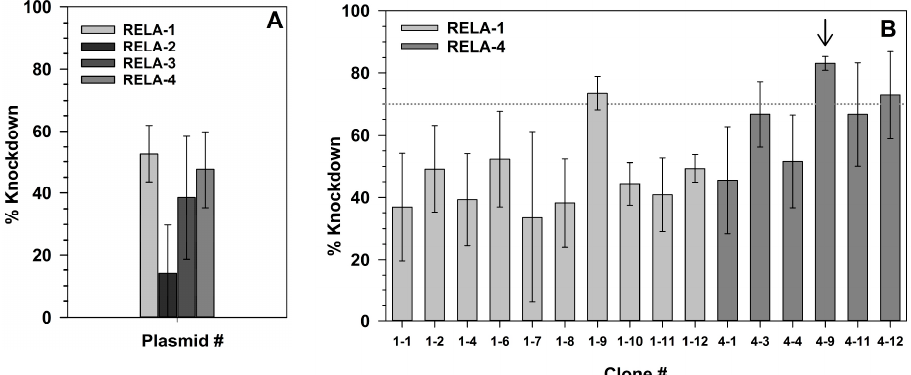
Figure 3. Verification of RelA knock-down on messenger RNA (mRNA) level after transfection of HEK-pNF- κ B-d2EGFP/Neo L2 cells with RelA short-hairpin RNA (shRNA) plasmids. Polyclonal